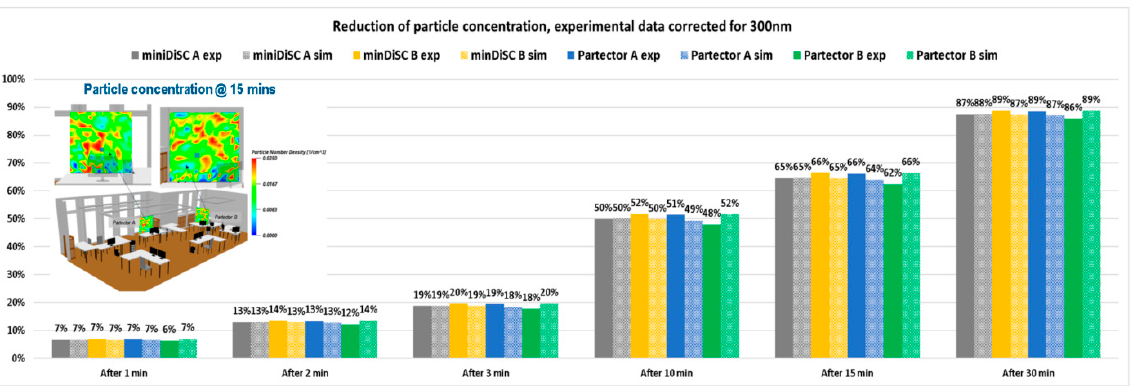
Figure 9. Reduction in the particle concentration after different operation times, determined by experiment and simulation.